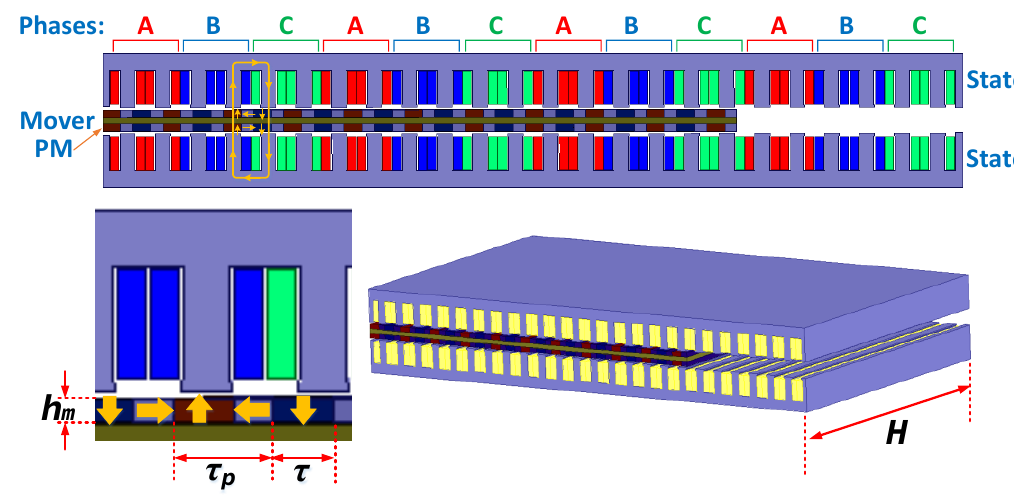
Figure 12. Axial cross-section 2D diagram and flux lines of the PMSLM.